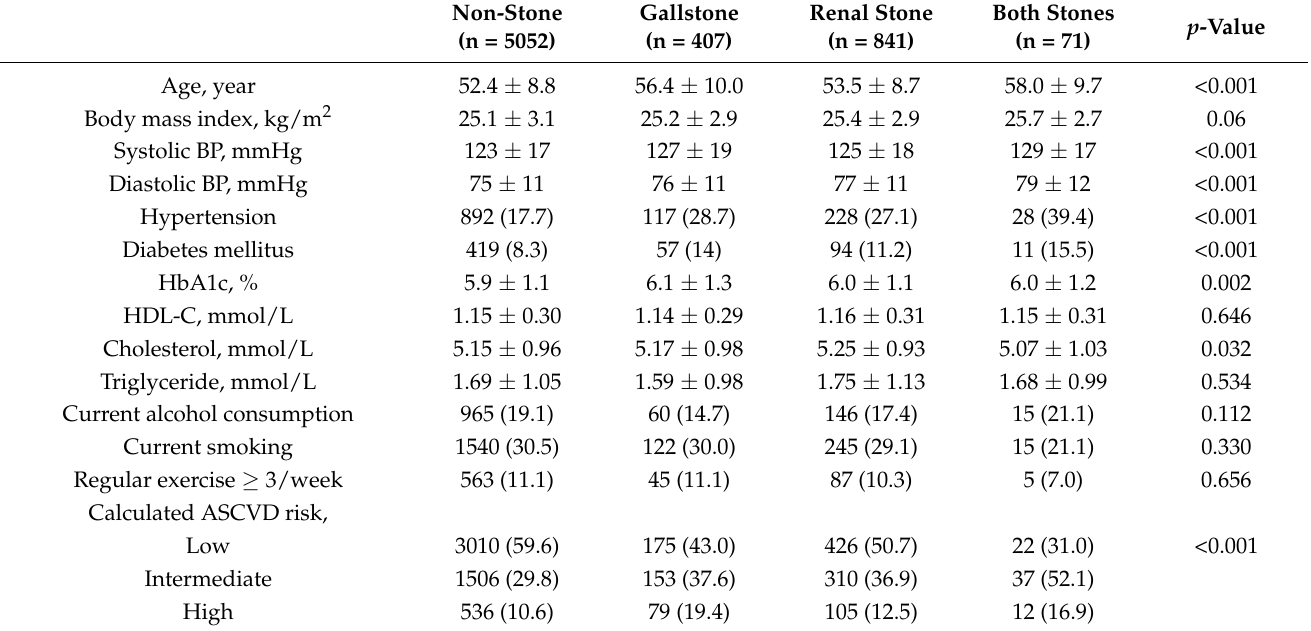
Table 1. Comparison of clinical parameters between males classified according to the possession of renal stones and